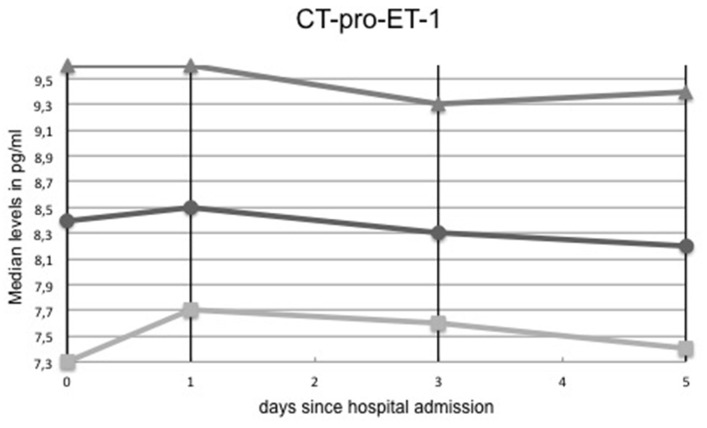
CT-pro-ET-1 levels over time. Circles indicate median CT-pro-ET-1 levels, squares lower 95%-confidence interval limits and arrows upper confidence interval limits, respectively.